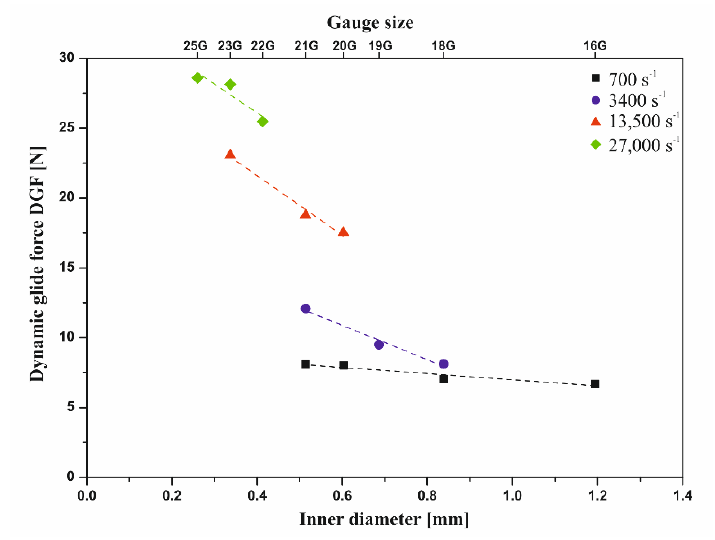
Figure 5. Influence of the needle diameter on the injection process under constant flow conditions expressed by the shear rate value.